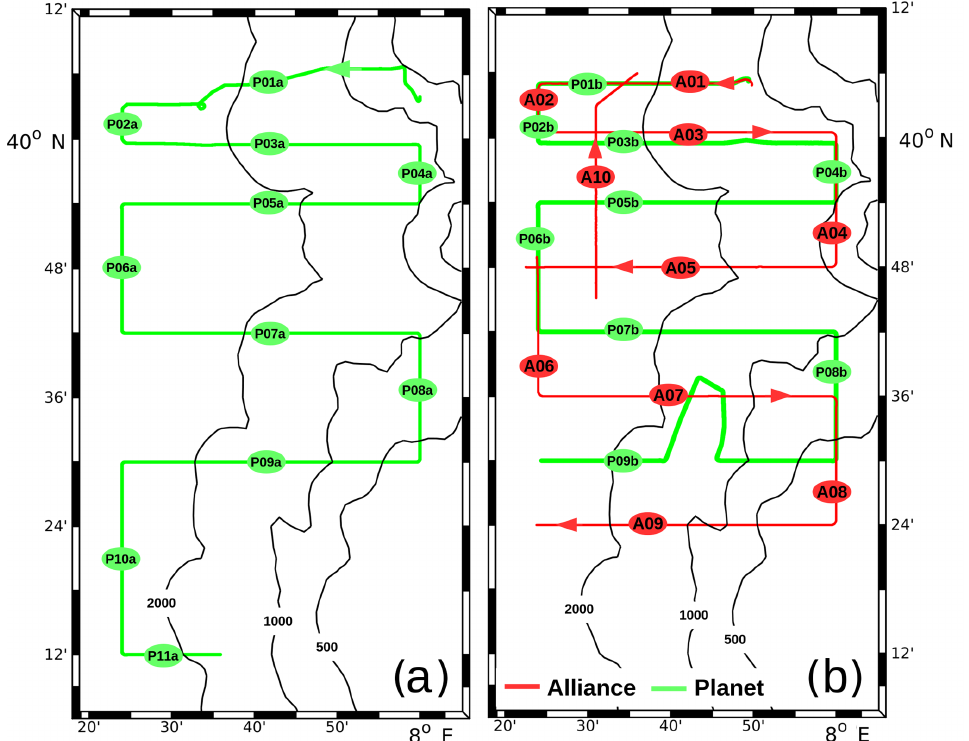
Figure 8. (a) CTD chain track of Planet during Leg 2. Tracks are numbered consecutively P01a–P11a. (b) CTD chain tracks P01b–P09b of Planet and ScanFish tracks A01–A10 of Alliance during Leg 3. Black lines indicate water depth